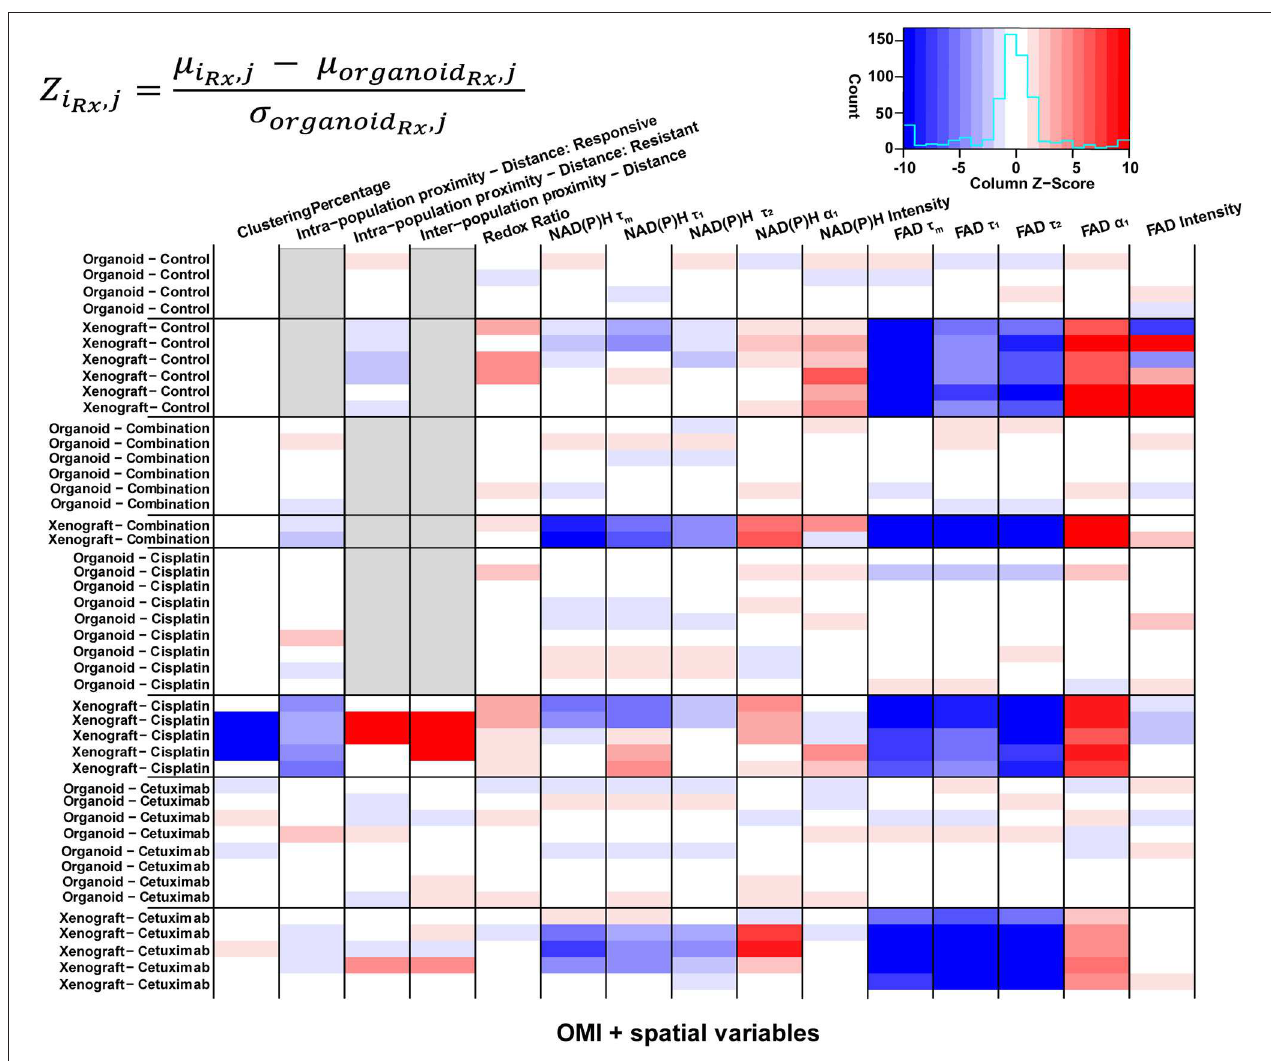
FIGURE 7 | Z-scores of metabolic and spatial variables in control and treated xenografts and organoids. Heatmap of Z-scores across treatment groups and model systems (organoid and xenograft). Each Z-score is calculated for each sample of a given treatment group (i Rx ) and variable (j) as the difference between the mean variable per sample and the mean variable across all organoids of the corresponding treatment group (organoid Rx ) divided by the standard deviation of the organoid treatment group. Z-score differences within a single treatment group represent variability across samples. Gray boxes indicate samples without a value for a given variable, specific to xenograft and organoid treatment groups with a single